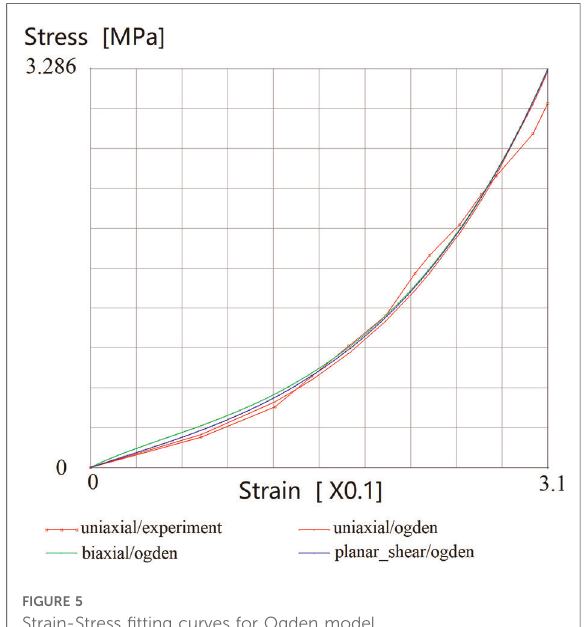
FIGURE 5 Strain-Stress fi tting curves for Ogden